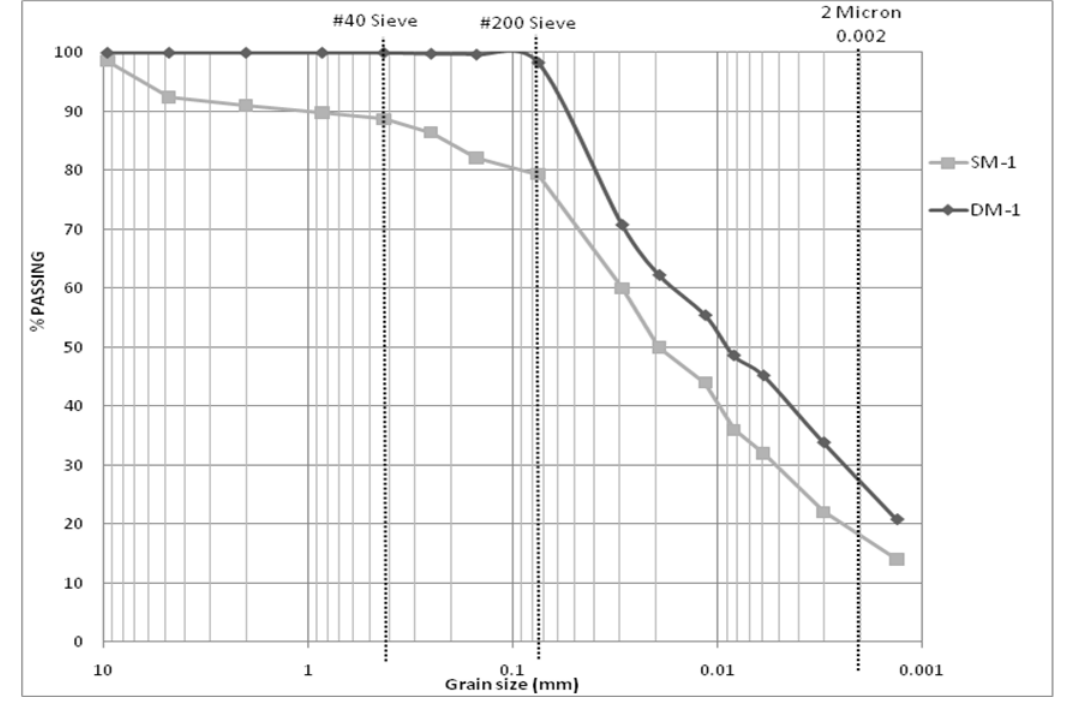
Figure 3. Comparison of grain size distributions: manually processed drilled sample (DM-1) and manually processed sample collected at the stockpile